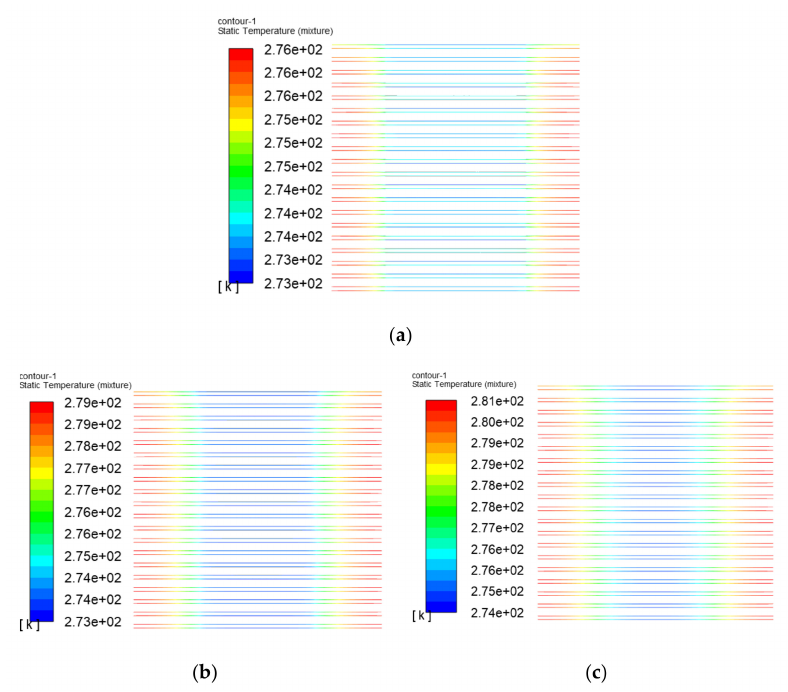
Figure 17. Temperature contours of the ETF at di ff erent times; ( a ) t = 24 s, ( b ) t = 32 s, ( c ) t = 36 s.